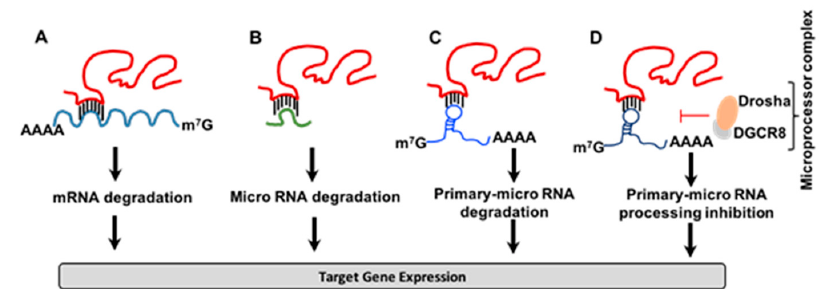
Figure 2. Regulation of gene expression by Transcribed-Ultra Conserved Regions (T-UCRs). T-UCRs regulate gene expression by ( A ) direct interaction with 3 ′ UTR of specific mRNA, ( B ) trapping miR, ( C ) degradation of primary miR or ( D ) inhibition of primary miR processing mechanism by microprocessor complex.